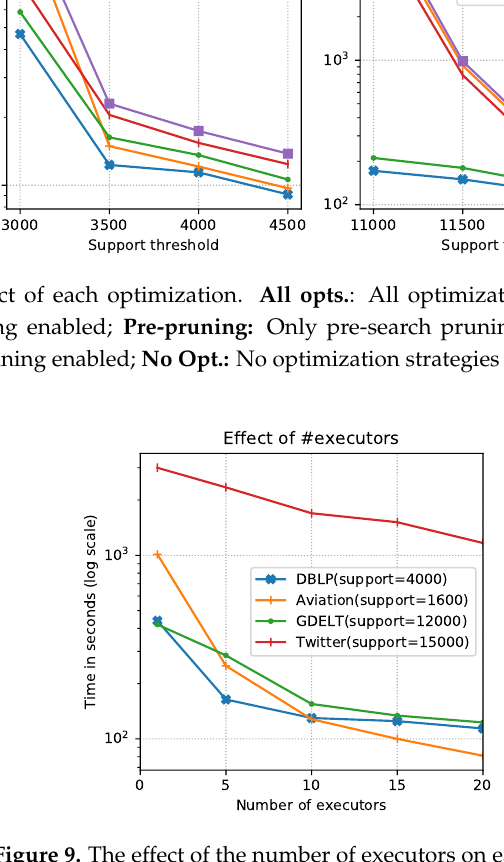
Figure 9. The effect of the number of executors on each